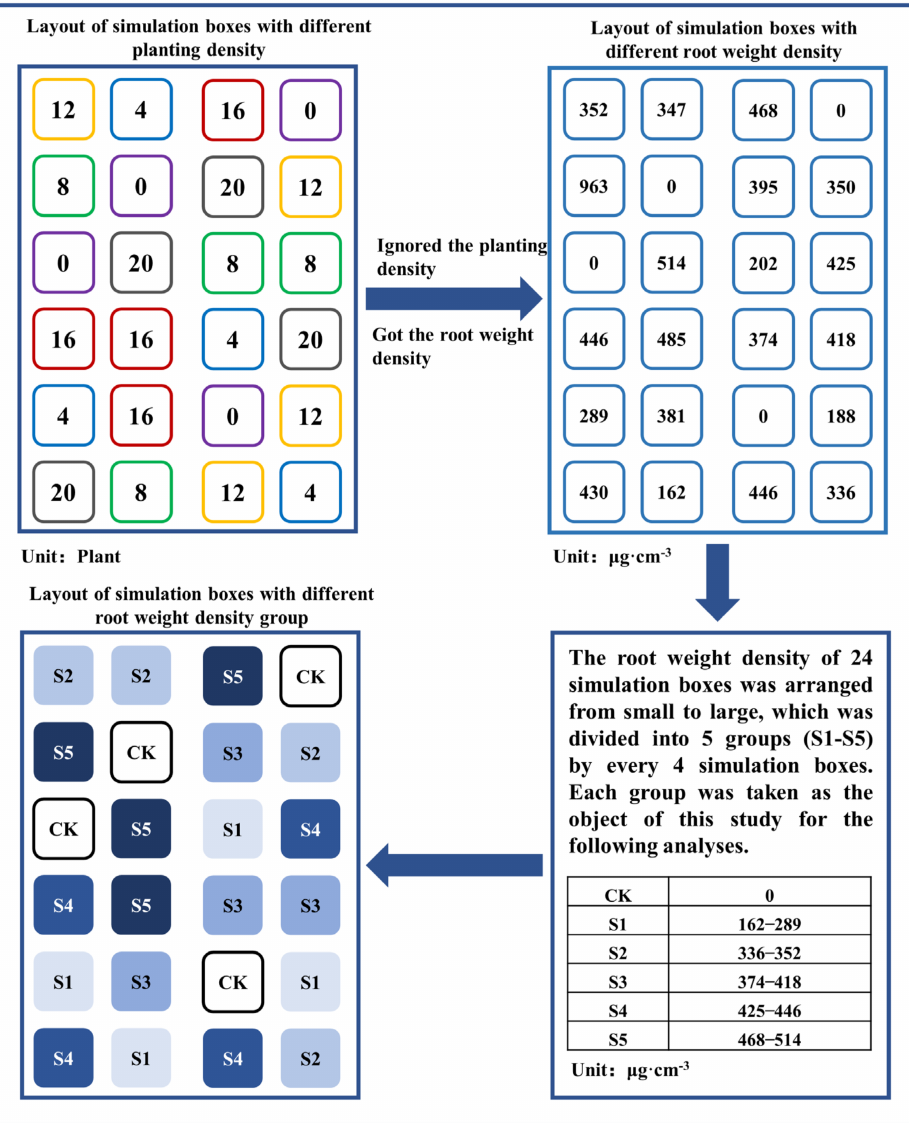
Figure 4. The method of grouping simulation boxes with different planting densities according to root weight